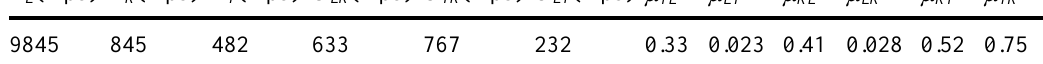
Table 1. 12 elastic constants of larch wood